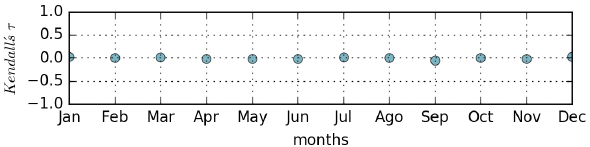
Figure 8. Correlation between updates and views of the 1000 most popular Wikipedia (2016)